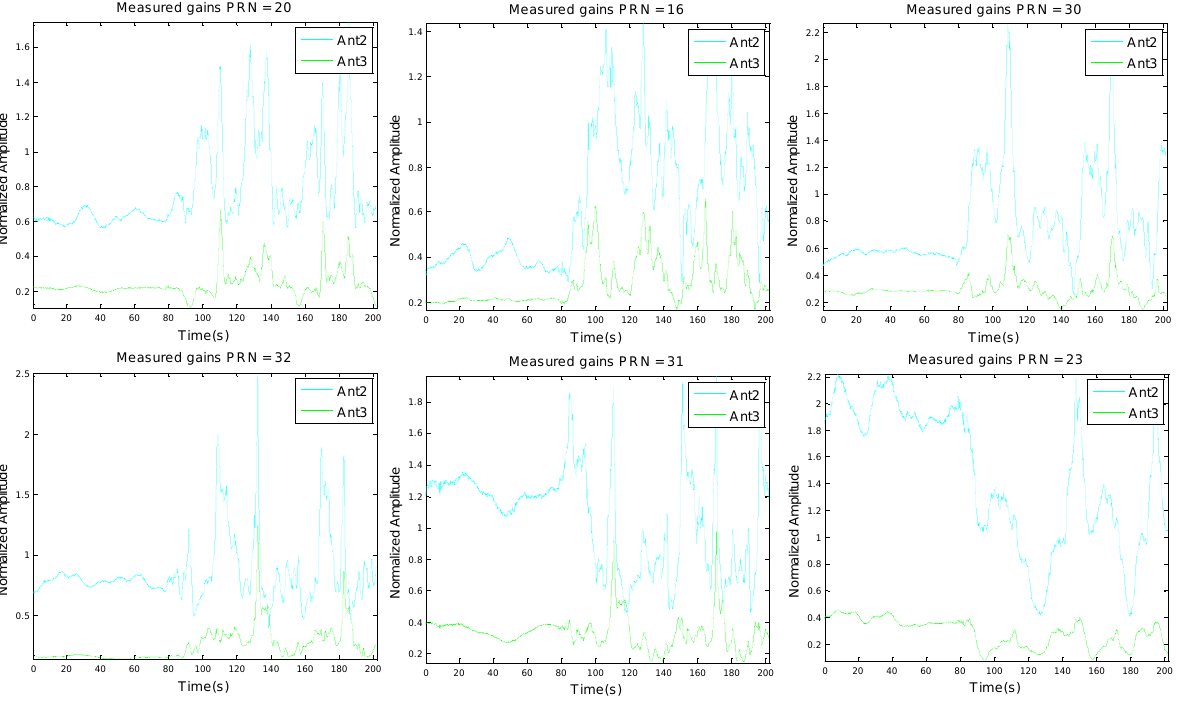
Figure 7. Measured amplitudes for Antenna 2 and Antenna 3 for PRNs 20, 16, 30, 32, 31 and 23.